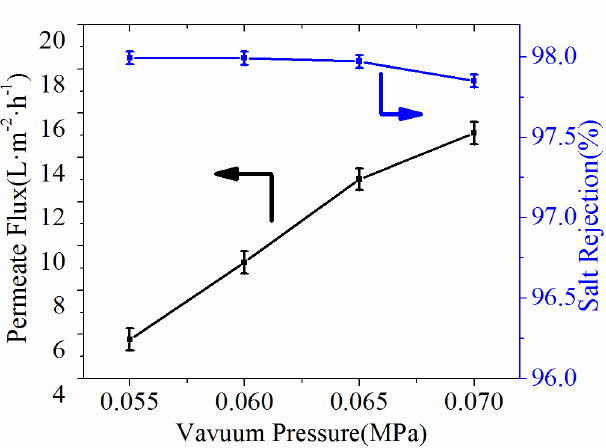
Figure 10. Effect of vacuum pressure on the permeate flux and salt rejection (NaCl concentration, 3.5 wt.%; feed temperature, 80 °C).